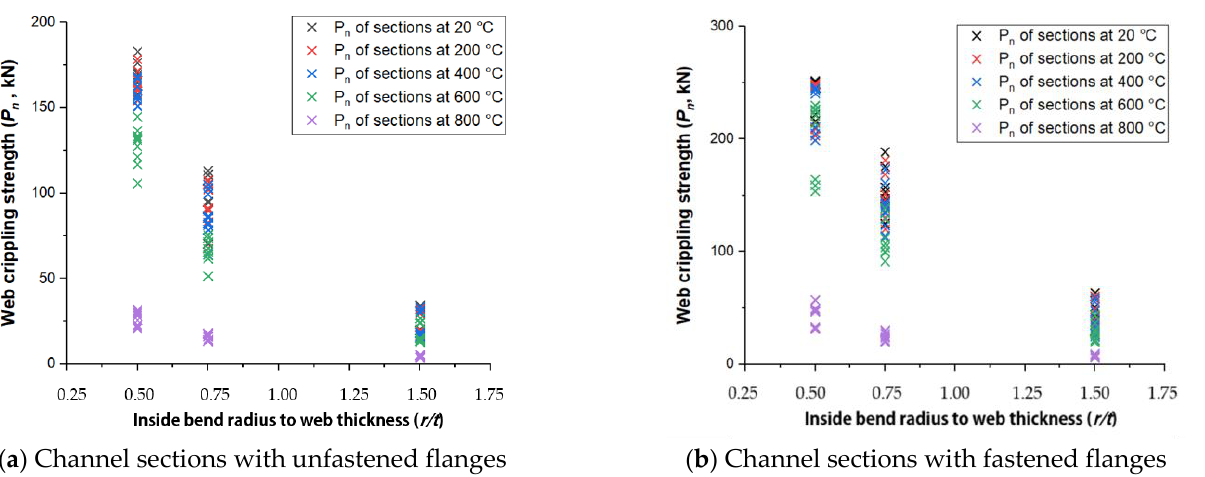
Figure 9. Ratio of r/t against web crippling strength.